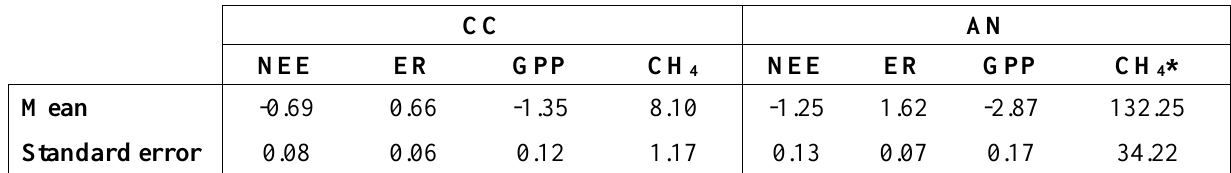
Table 2. Summary of carbon gas flux data from the Cayambe Coca (CC) and Antisana (AN) sites. Net ecosystem exchange (NEE), ecosystem respiration (ER) and gross primary production (GPP) are expressed in g CO m -2 hr -1 , and positive values represent release by the ecosystem. Methane (CH 2 CH m -2 d -1 , and positive values represent loss from the ecosystem. Note that these data represent daytime- 4 only values; carbon dioxide (CO ) flux would be higher if night-time respiration were considered. The mean 2 values represent averages of